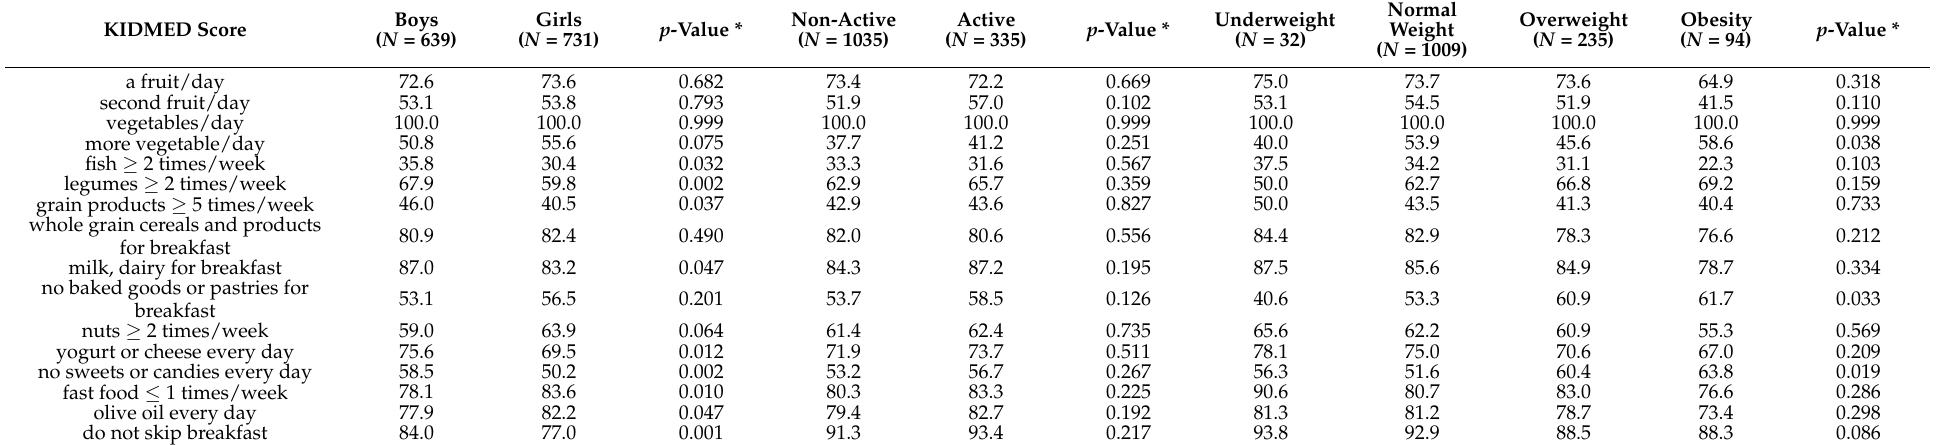
Table 3. Compliance with KIDMED score items among schoolchildren ( N = 1370) according to gender, physical activity level and BMI-for-age classes